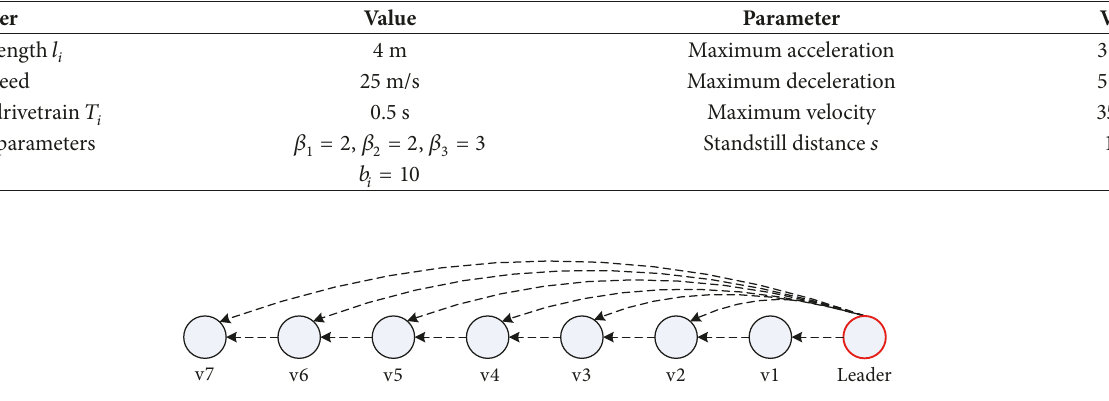
Table 1: Parameters for the traffic simulation and consensus control algorithm.